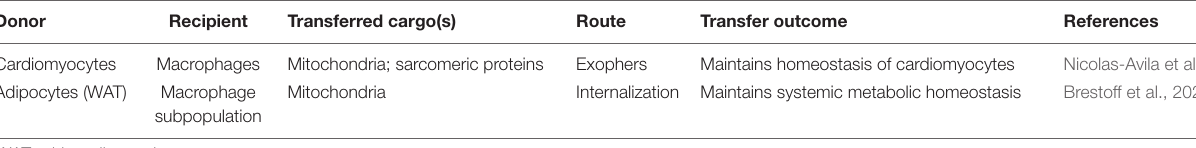
TABLE 1 | Intercellular mitochondrial transfer in macrophages under physiological conditions.